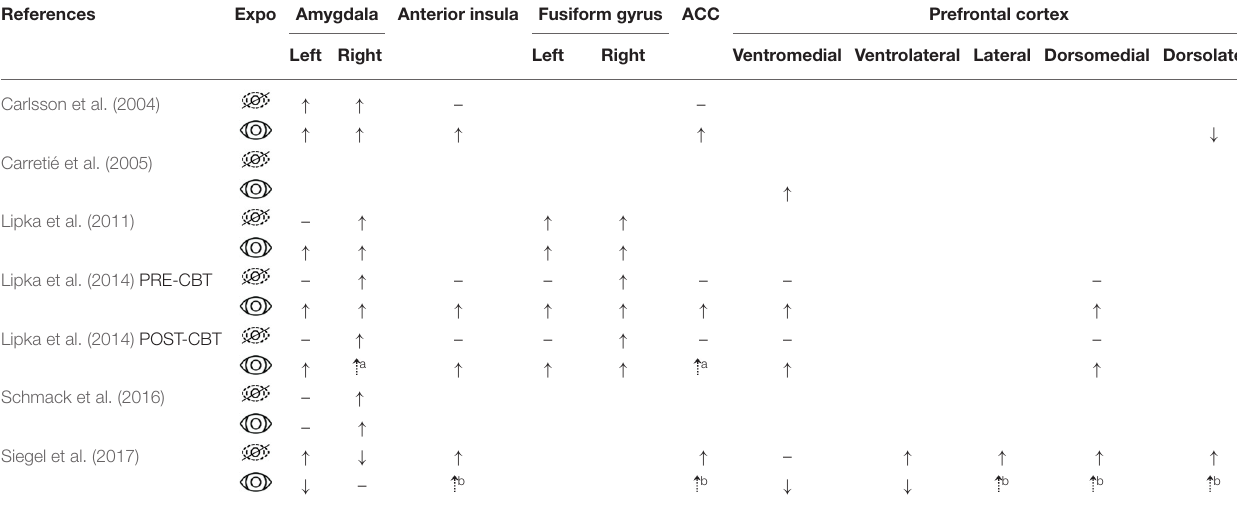
TABLE 4 | Brain areas relevant for processing of phobic